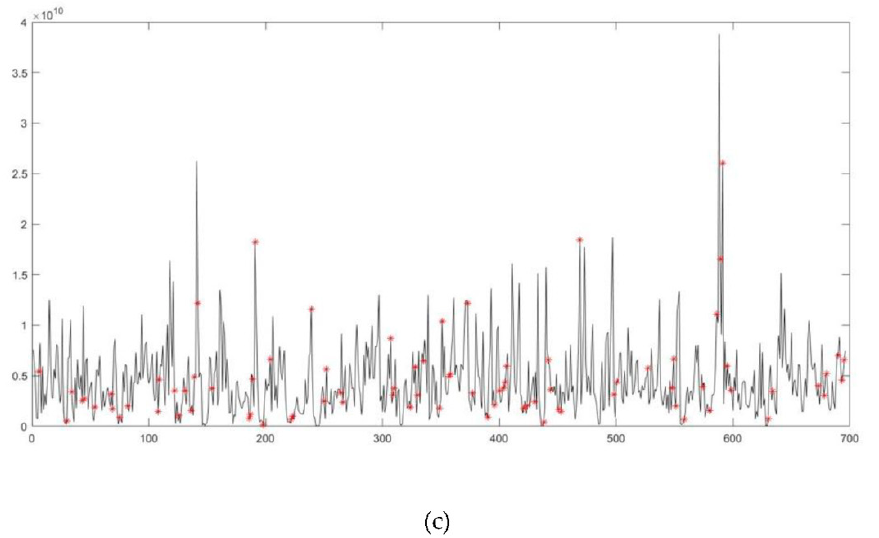
Figure 12. Anomaly detection of three types of KPI data. ( a ) Anomaly detection of average # of users. ( b ) Anomaly detection of average # of activated users. ( c ) Anomaly detection of cell PDCP traffic.